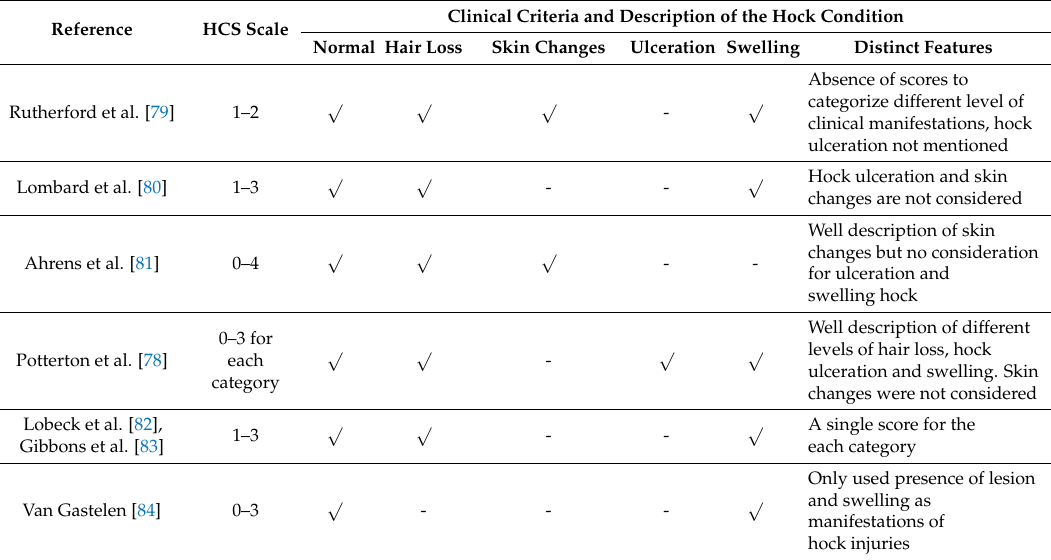
Table 1. Commonly-used hock condition scoring (HCS) systems and the criteria